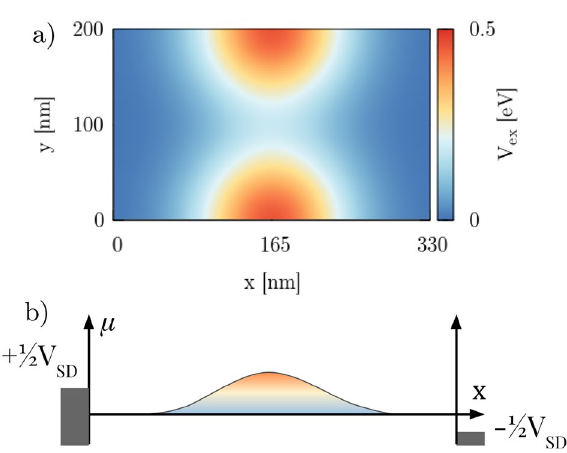
0.5 eV, in the system of size 200 nm by 330 = V SD / 2 ) are marked on both ±